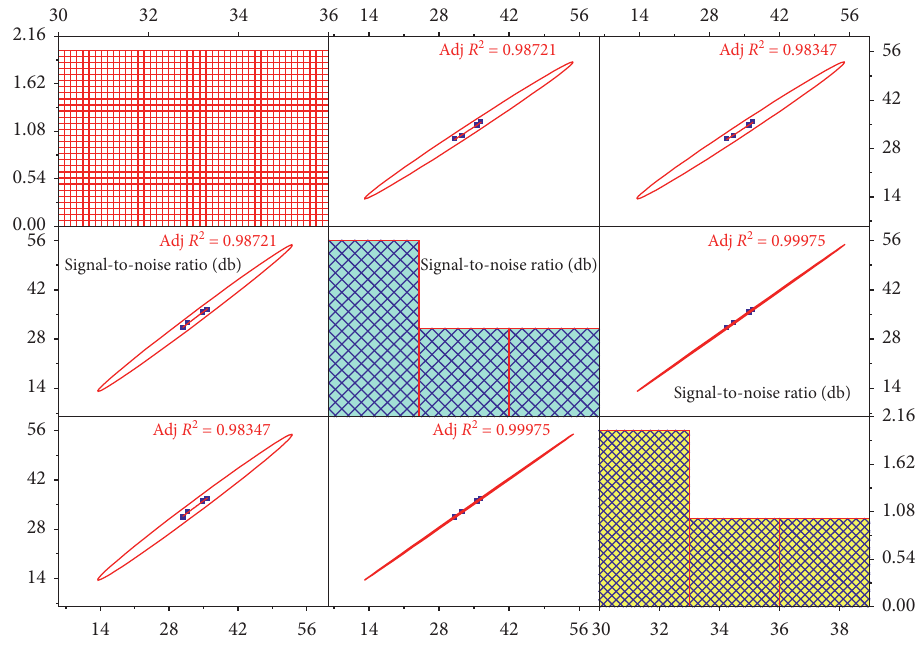
Figure 9: Peak signal-to-noise ratio analysis